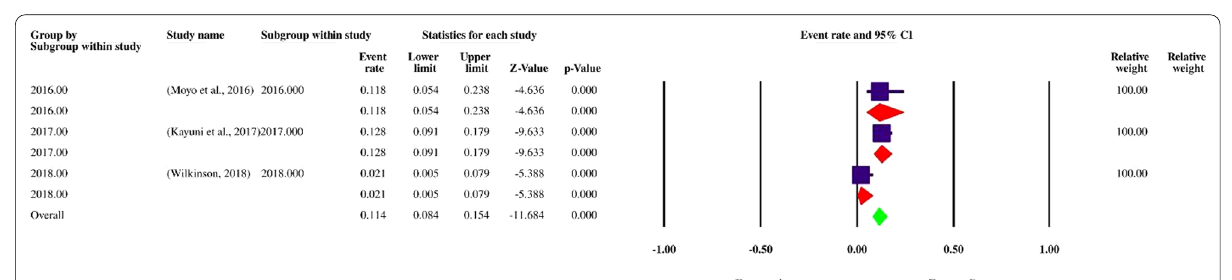
Fig. 7 Forest plot of year-based prevalence in Malawi (2016–2020)